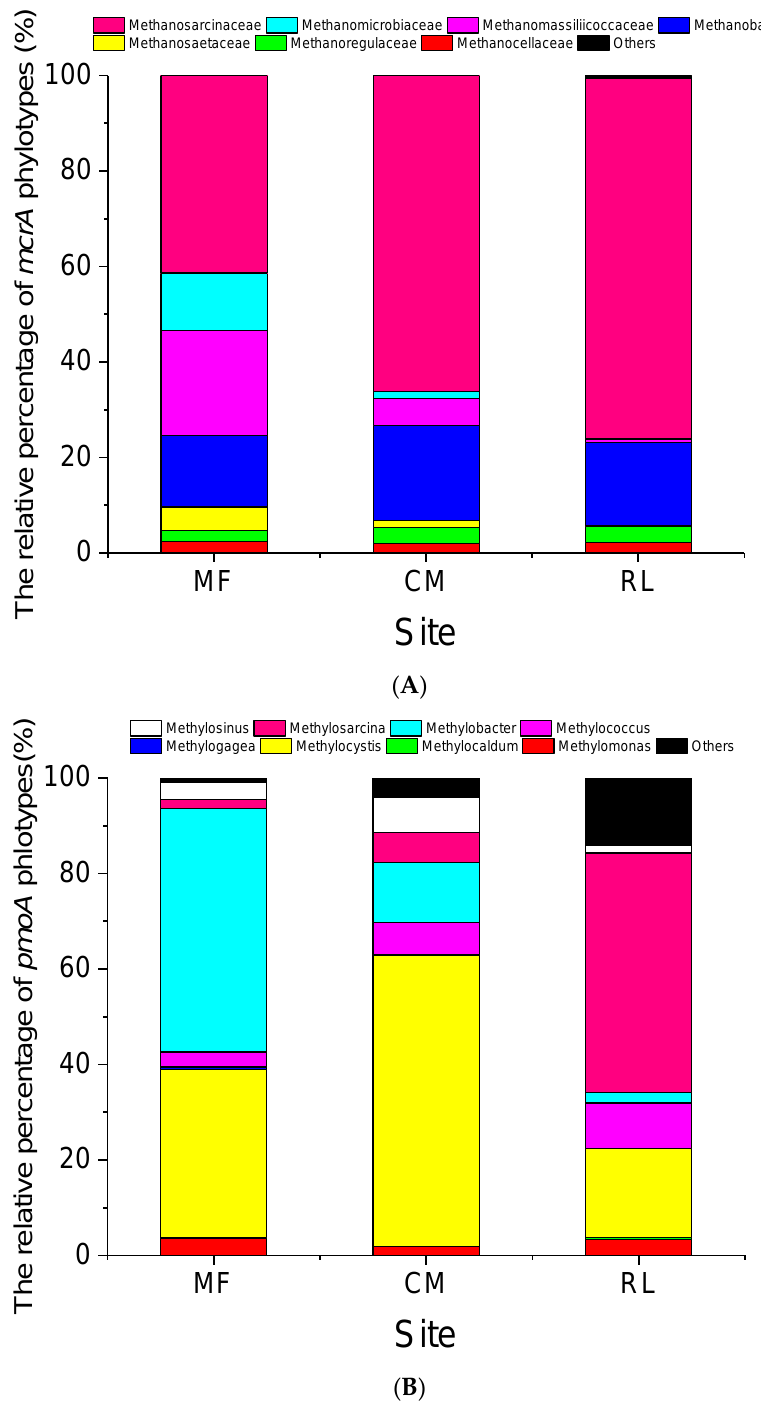
Figure 3. The relative percentage of Methanogens ( A ) and Methanotrophs ( B ) phylotypes at three sites in the Dongting floodplain. The data is average value across a 0–30 cm soil profile. Site abbreviations: MF: mudflat, CM: Carex meadow, RL: reed land.